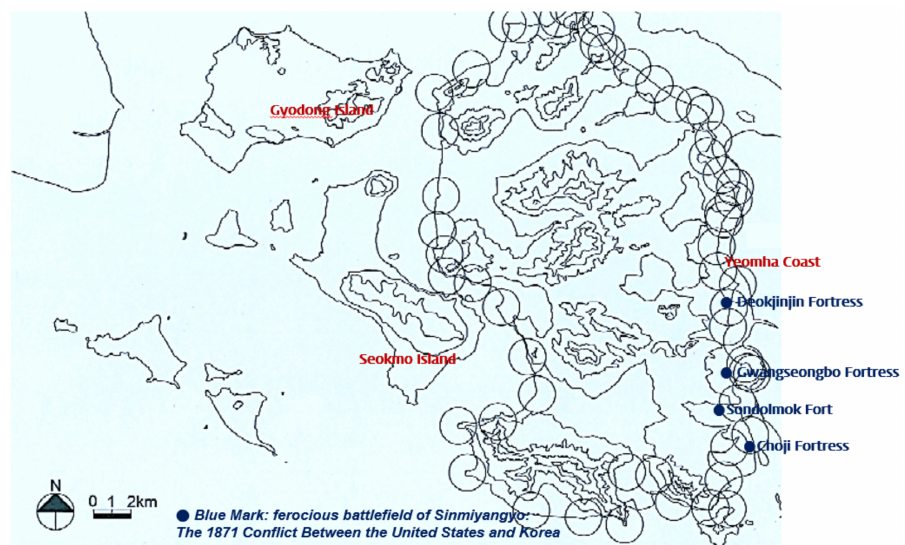
Figure 13. The Range and Fire Network of Frankish Bulranggi cannons made by the Dondae forts along the topography of Ganghwa